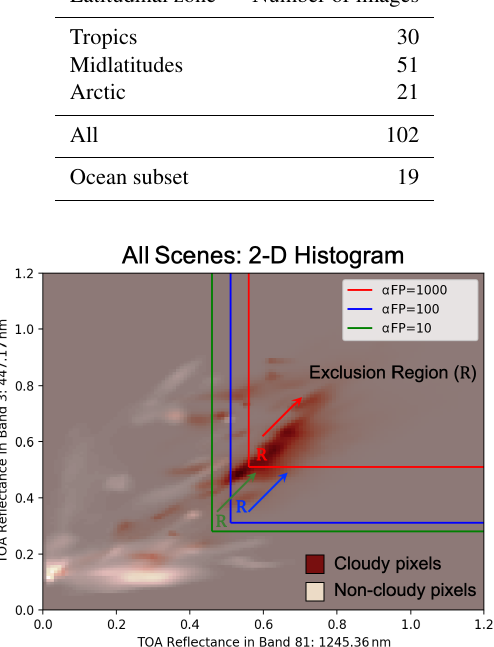
Figure 4. A two-dimensional histogram of cloud and non-cloud dis- tributions for the Hyperion subset. The color gradient indicates rel- ative frequency. The exclusion region for various false positives are shown as colored rectangles: α FP = 1000 (red), α FP = 100 (blue), α FP = 10